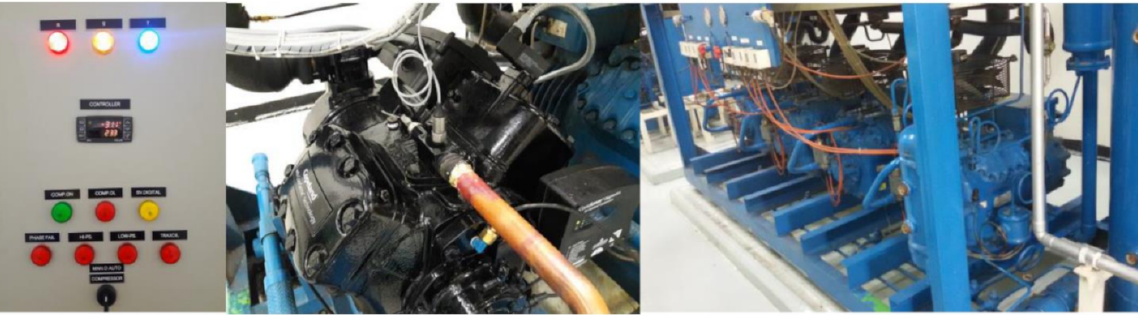
Figure 5. Digital compressor rack with digital compressor and digital controller No.1